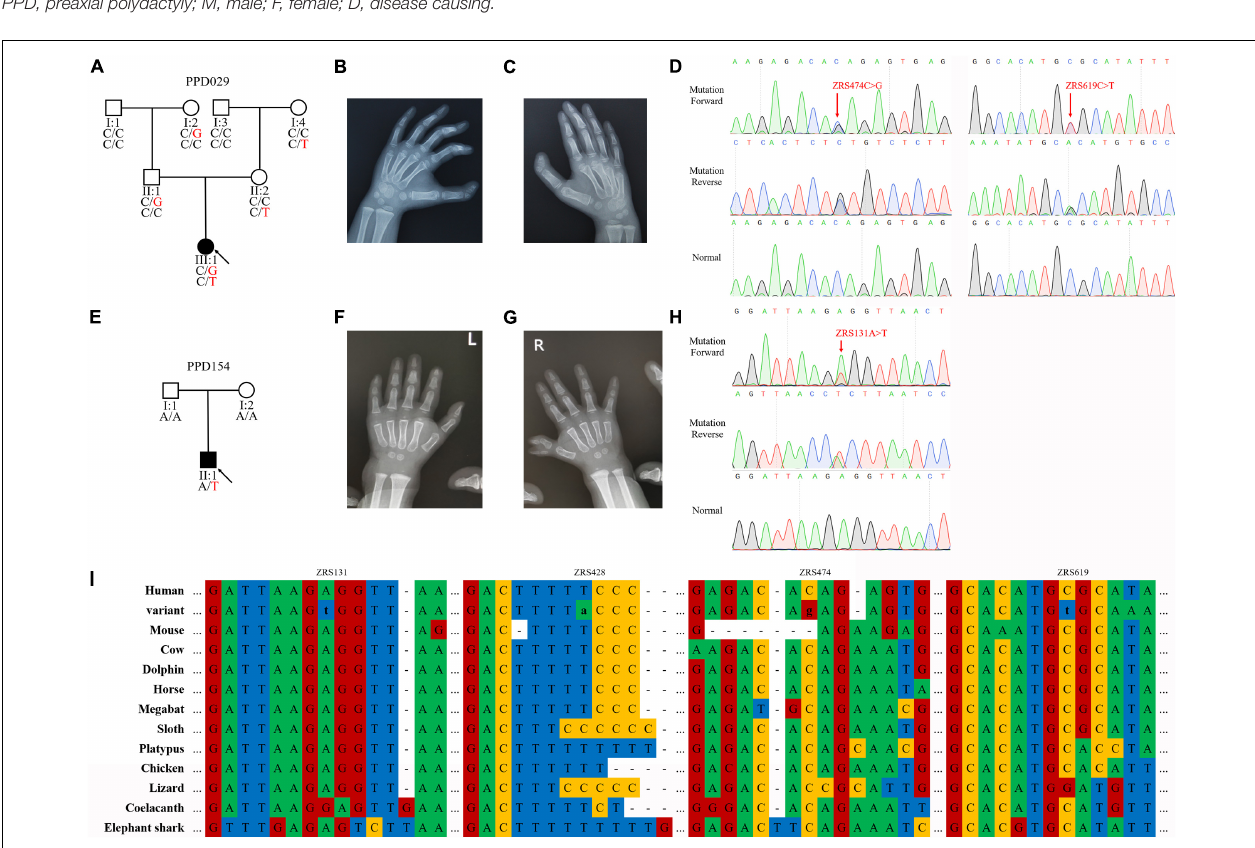
FIGURE 2 | ZPA regulatory sequence (ZRS) variants identified in preaxial polydactyly (PPD) families. (A,E) Pedigrees of PPD families (PPD029 and PPD154). “PPD029” and “PPD154” were PPD family numbers. Squares indicate male family members and circles indicate female family members. The black symbols represent the affected members and arrows indicate probands. Genotypes are identified by letters and a slash, with red representing variants. (B,C,F,G) Symptoms of patients. PPD029 had bilateral triphalangeal thumbs and PPD154 exhibited PPD I on the right hand. (D,H) Sequencing results of ZRS variants using Sanger sequencing. (I) Species conservation analysis of mutant base sites in